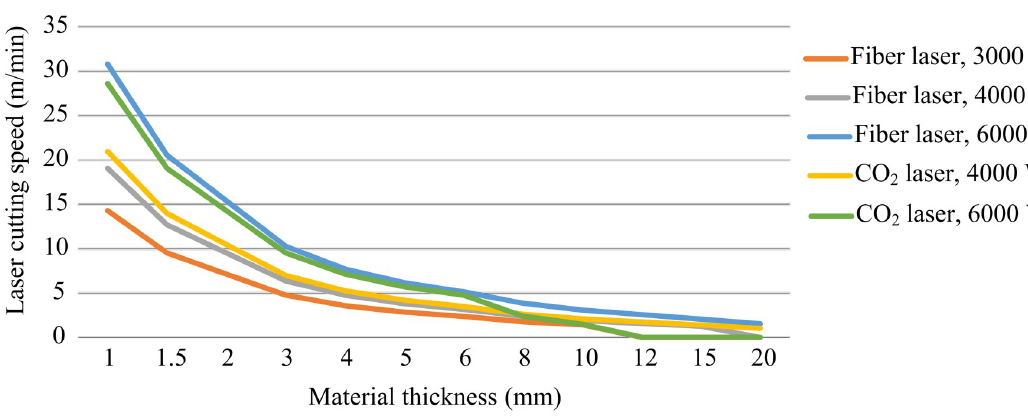
Fig 2. Relationship between laser cutting speed vs thickness for different laser types and power, for steel material.